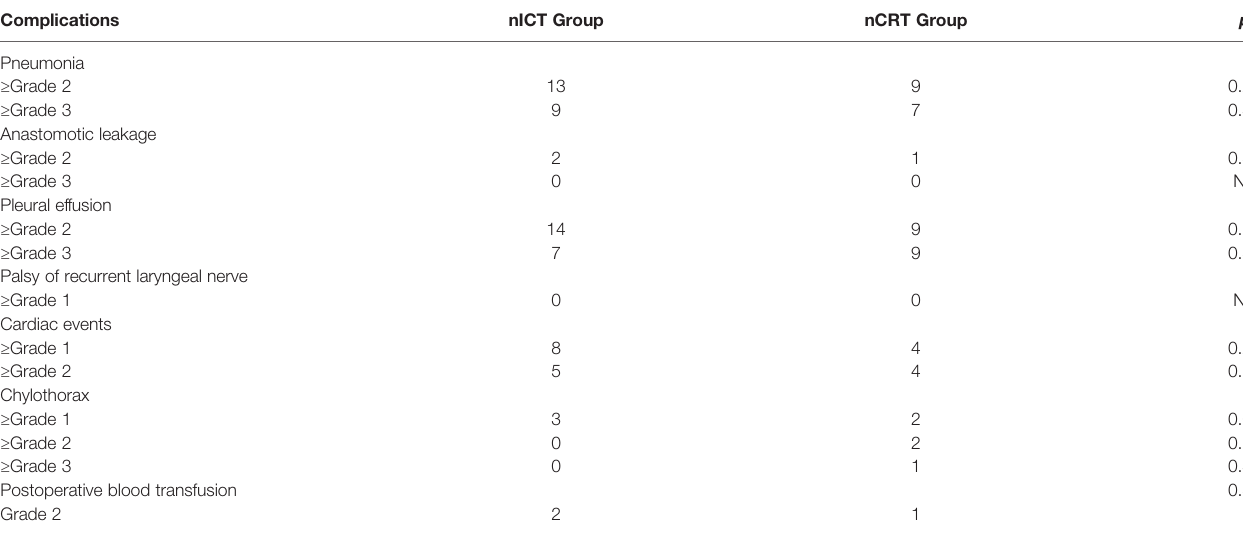
TABLE 3 | Postoperative complications within 30-day after operation evaluated by Clavien – Dindo classi fi cation.